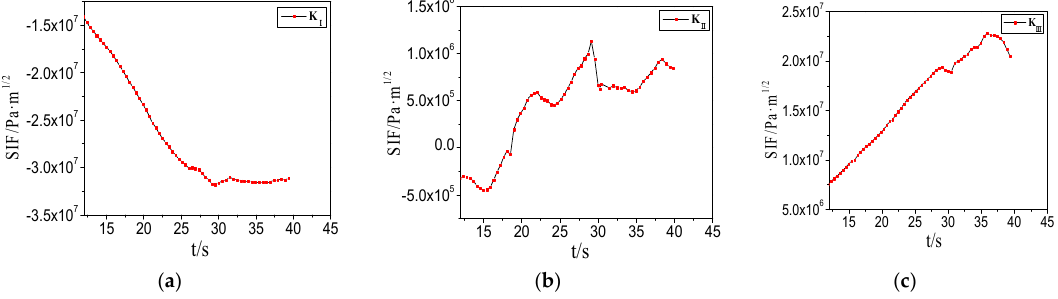
Figure 20. The stress intensity factors (SIFs) of the crack in the heating process. ( a ) K I ; ( b ) K II ; ( c ) K III .